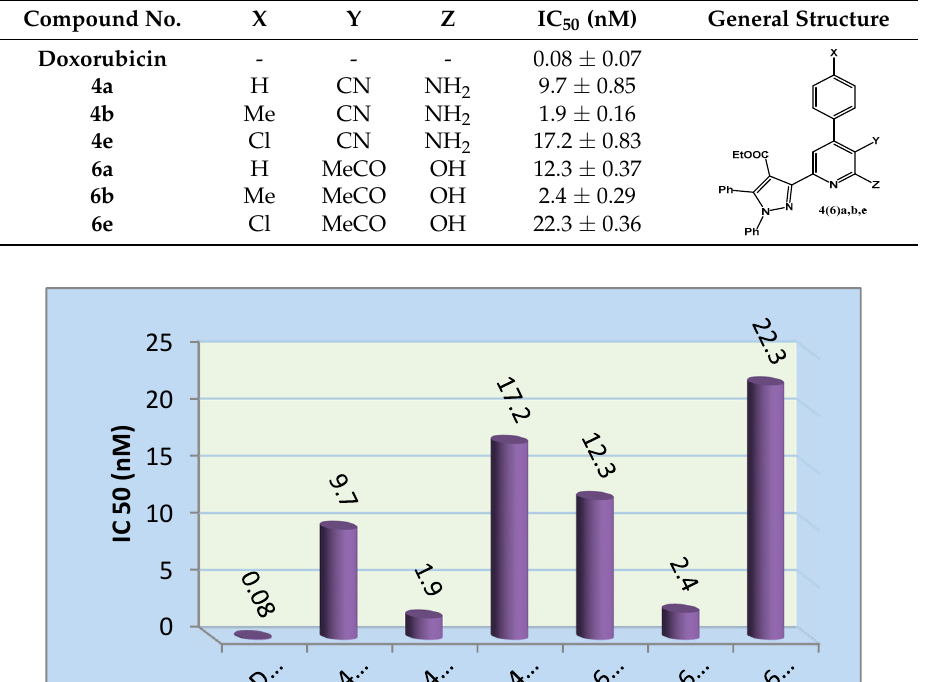
Table 1. IC 50 values of tested compounds 4 and 6 ± standard deviation against HEPG2-1. Compound No.